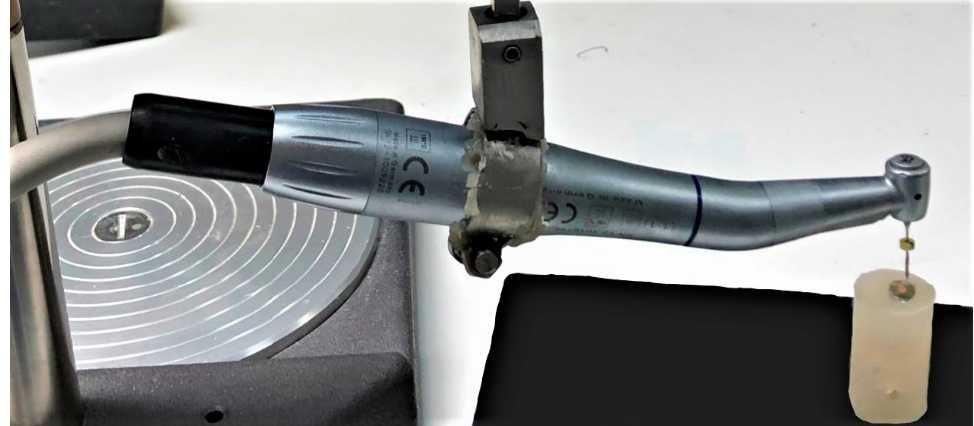
Figure 2. Standardized post space preparation with customized hand piece attached to dental surveyor.